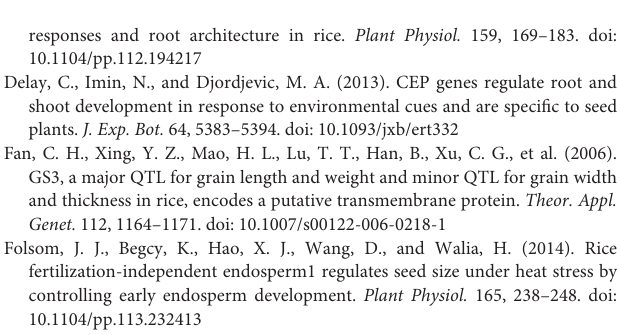
Figure S1 | MS data of synthetic CEP peptides (DSRPTAPGNSPGIGN). Figure S2 | Nucleotide sequences alignment of the rice CEP genes. (A) The sequences of OsCEP1, 2, 3, and 5 identified in Ogilvie’s paper (red) are the same as those identified by Delay et al. (2013) and Roberts et al. (2013) (black). (B) The sequences of OsCEP6 and 7 identified in Ogilvie’s paper (red) are different from those of OsCEP6 and 7 identified by Delay et al. (2013) and Roberts et al. (2013) (black). Figure S3 | Expression patterns of 14 rice CEP s as determined by Rice qTeller (http://qteller.com/rice/). Figure S4 | Histological analysis of the rice grain and expression profile of syncytial and cellularization stage specific genes. (A) The OsCEP6.1 overexpression line exhibited slower cellularization than that of the control. (B) The expression level of syncytial stage specific MADS-box genes ( OsMADS82 and OsMADS87, but not AGL36 ) was significantly higher in the transgenic line than in the control at 2 DAP, whereas the expression level of the cellularization stage specific gene STRACH SYNTHASE II ( SSII ) was higher at 5 DAP but lower at 8 DAP in the transgenic line compared with the control. Figure S5 | Scanning electron microscopy analysis revealed that neither the starch granule nor the starch arrangement was obviously different between the control (ZH17) and the transgenic lines (#5). Figure S6 | Quantitative RT-PCR analysis revealed that eight cell-cycle-related genes, including five G1/S-phase genes ( CDKA1 , CAK1 , CAK1A , CYCT1, and CYCD4 ) and three G2/M-phase genes ( CYCIaZm , CDKB and CYCB2.1 ), were significantly down-regulated in the transgenic line compared with the control. The expression levels were determined using 6–8cm young panicles from at least five plants, the values are means ± SD, ∗ P < 0.05 , ∗∗ P < 0.01 .The inner control genes was the UBQ gene. Figure S7 | (A) OsCEP2 (EAY90324.1, 93–11) and OsCEP4 (AAP04189.1, Nipponbare) have only one SNP in their nucleotide sequences. (B) OsCEP7 (Os01g0203400.1, Nipponbare) and OsCEP8 (EAY72936.1, 93–11) have 98% similarity between each other. Figure S8 | Quantitative RT-PCR analysis revealed that five grain size related genes ( GL3.1 , SG1 , GW2, GW5, and GS3 ) were down-regulated in the two transgenic lines (#5and #6) compared with the control. Expression levels were determined using 6–8cm young panicles from at least five plants, the values are means ± SD, ∗ P < 0.05 , ∗∗ P < 0.01 . Table S1 | Primer pairs used in this study. Table S1 | The rice CEP genes identified in the previous study (Delay et al., 2013; Roberts et al., 2013; Ogilvie et al., 2014) and our study. Table S2 | Cell size and cell number in the